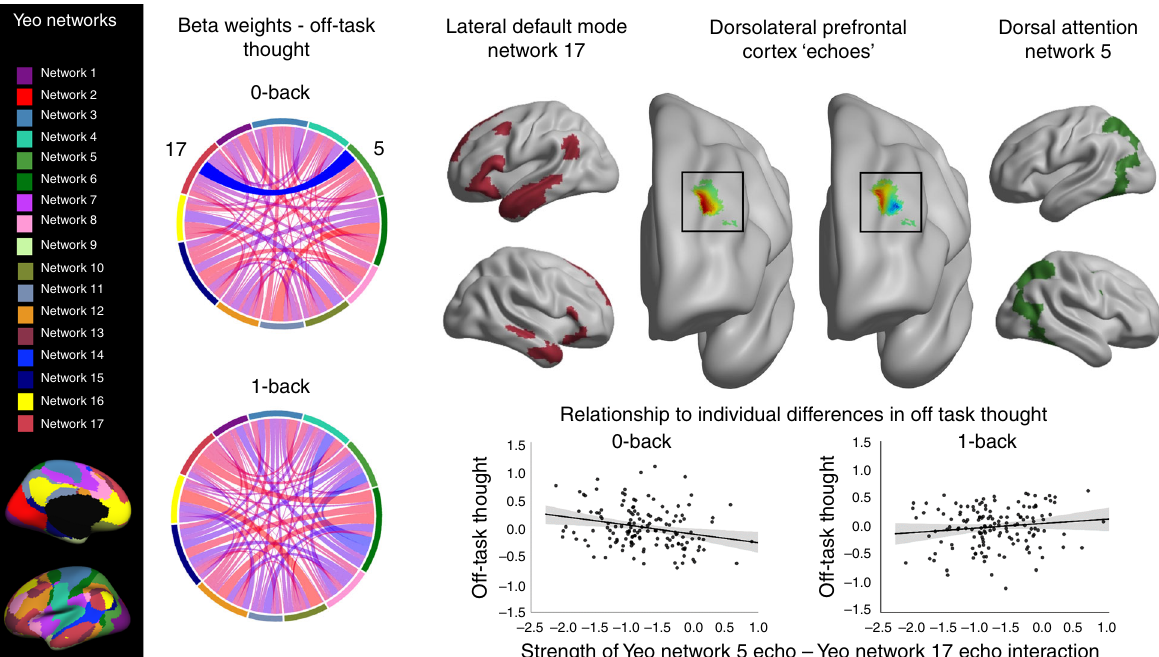
Fig. 3 Segregation between echoes of the dorsal attention network and lateral temporal elements of the DMN relate to off-task thoughts in the 0-back condition. Analysis revealed a signi fi cant relationship between the correlation of Network 5 and 17 within left DLPFC and off-task thoughts during the 0- back. Chord diagrams represent beta-weights describing the relationship between the strength of pairs of network interactions and reports of thoughts in the 0-back and 1-back tasks. The signi fi cant relationship is highlighted (opaque). A key for the networks from Yeo et al. 33 is shown on the left, and the chord diagram colours correspond to these. A full description of these networks can be found in Supplementary Fig. 8